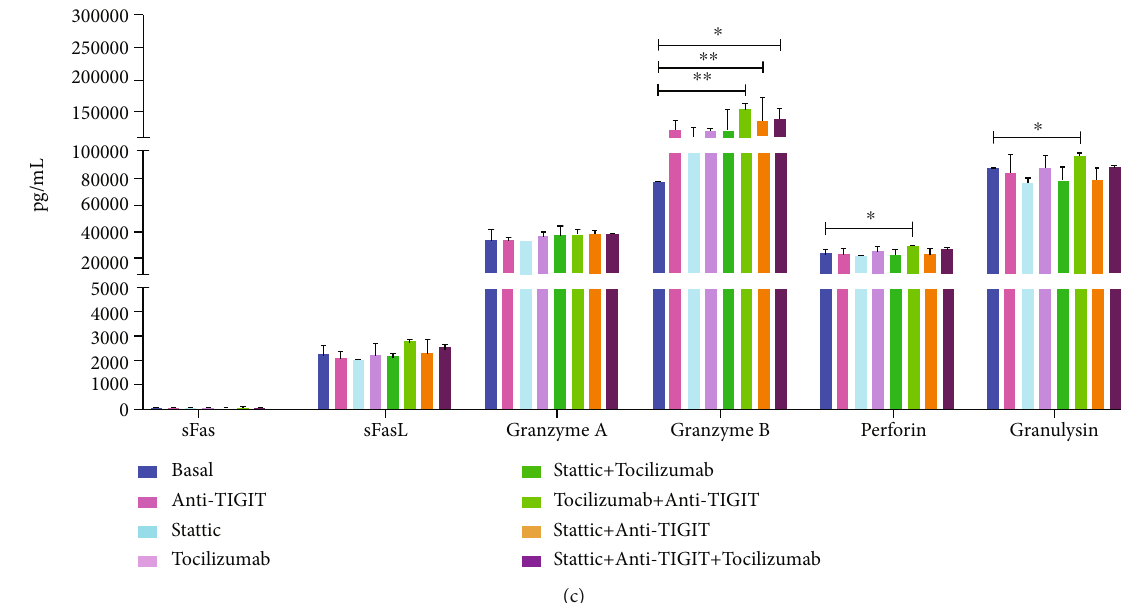
Figure 6: NK-92 cells increase the secretion of sFasL, granzyme A, granzyme B, and granulysin after treatment with stattic + Anti-TIGIT + Tocilizumab. (a) Evaluation of the levels of 13 soluble molecules related to the cytotoxic activity of supernatants from cocultures was carried out for 4 and 24h. (b) Increased secretion of soluble FasL, granzyme A, granzyme B, and granulysin in the treated groups compared to the basal group in the coculture supernatant at 4 h. (c) The production of granzyme B, perforin, and granulysin is signi fi cantly maintained for 24h in the treated groups. Data are shown as the mean ± SD . ∗ p < 0 : 05 , ∗∗ p < 0 : 01 , ∗∗∗ p < 0 : 001 (unpaired t